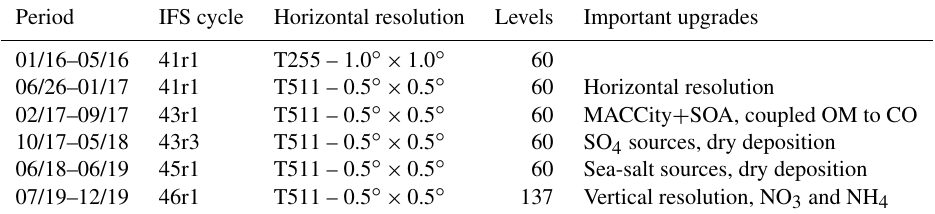
Table 1. Specification of relevant CAMS model runs for changes by successive cycles (see https://atmosphere.copernicus.eu/node/326/, last access: 25 March 2021) and specifically for cycle 46r1 https://atmosphere.copernicus.eu/node/472/ (last access: 25 March 2021), as described in Table 3 in Rémy et al. (2019). ASM is like CTR but additionally uses 4D-Var